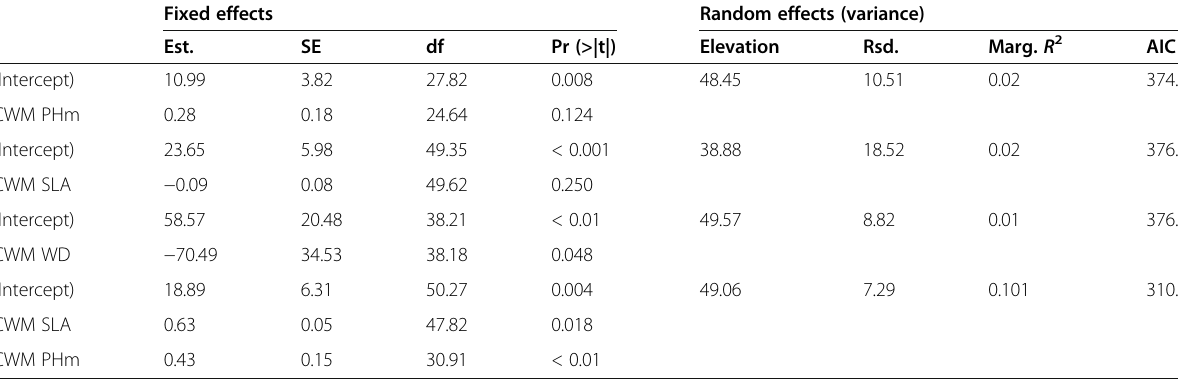
Table 4 The effect of functional dominance on AGC stock Fixed